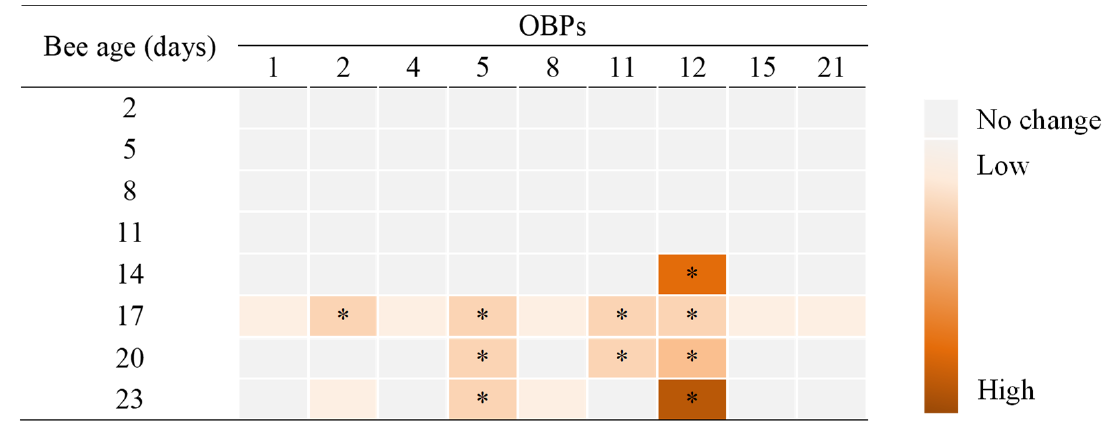
Figure 5. Heat-map illustrating the intensity of down-regulation of odorant binding proteins (OBPs) in the antennae of worker honey bees of different ages that were inoculated with DWV-A. Asterisks indicate significant differences (Bonferroni test, p < 0.05). Gene expression of OBPs in antennae of inoculated bees with DWV-A compared to non-inoculated bees.